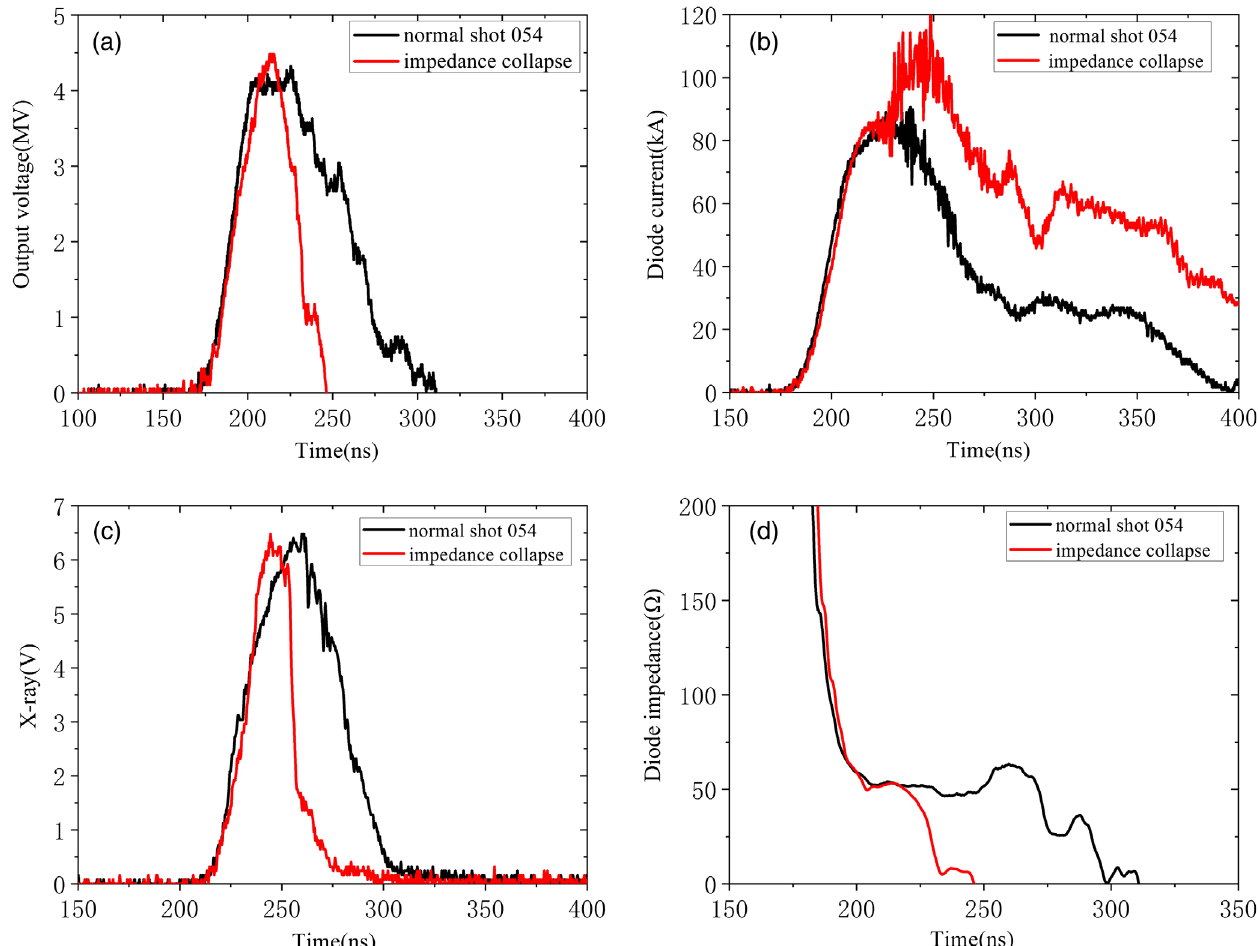
FIG. 9. Comparison of electrical measurements from the impedance-collapse shot 064 (red traces) and the normal shot 054 (black traces). (a) Output voltage, (b) diode current, (c) Compton detected x ray, and (d) calculated diode impedance profiles according to Eqs. (1) and